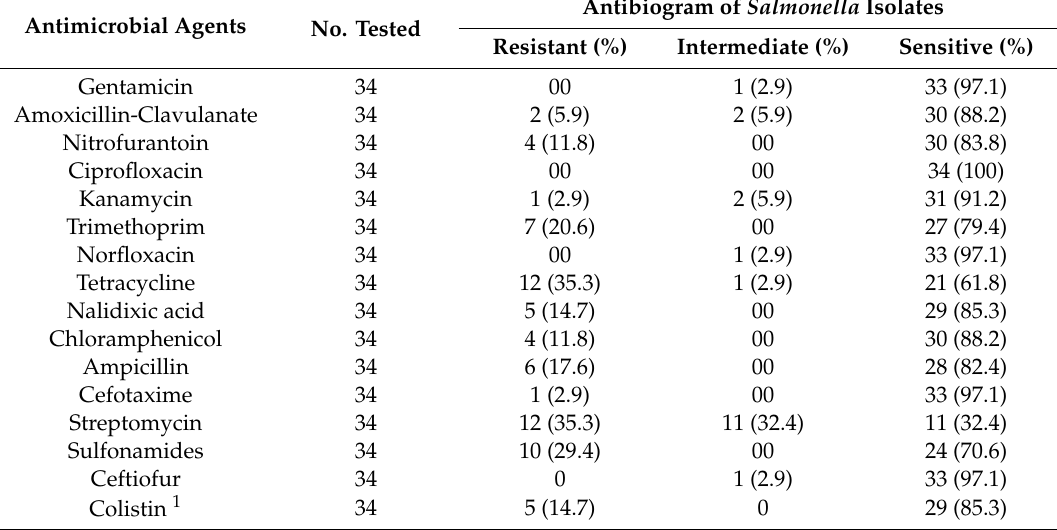
Table 1. Antibiogram of Salmonella isolates recovered from village chickens of the central and Southern Peninsular Malaysia.